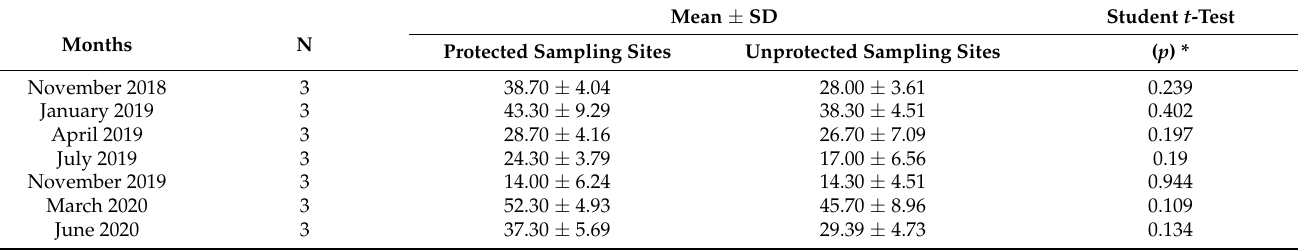
Table 3. Paired t -test of species richness between three protected and three unprotected sites (n = 3 for each). Mean = average species richness of the three study